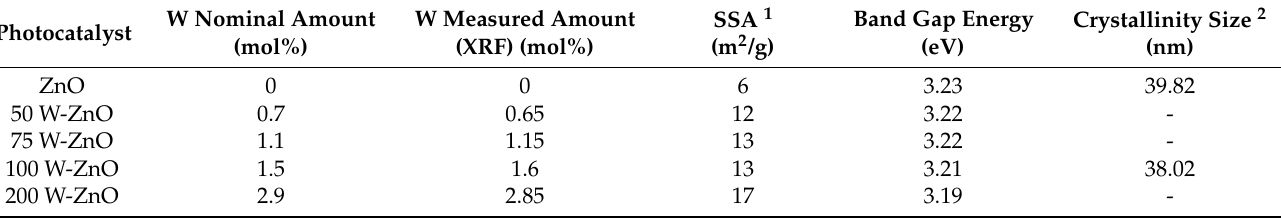
Table 1. Characteristics of the prepared